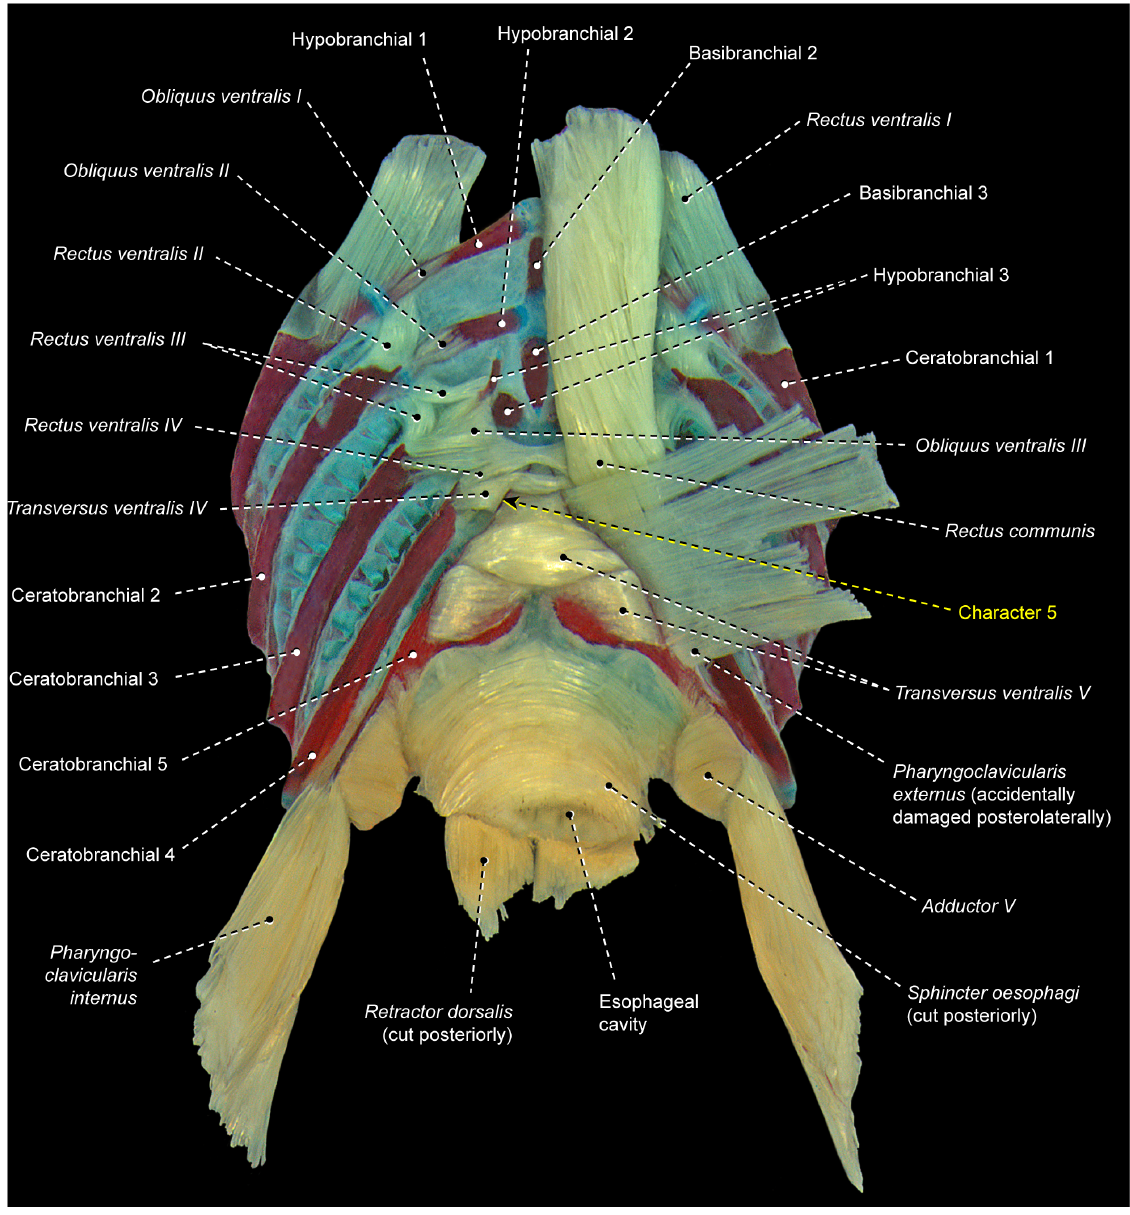
Figure 8. Branchial musculoskeletal system of Scartella cristata (Blenniiformes: Blenniidae). MZUSP 60573. Ventral view; right pharyngoclavicularis externus and rectus communis removed.